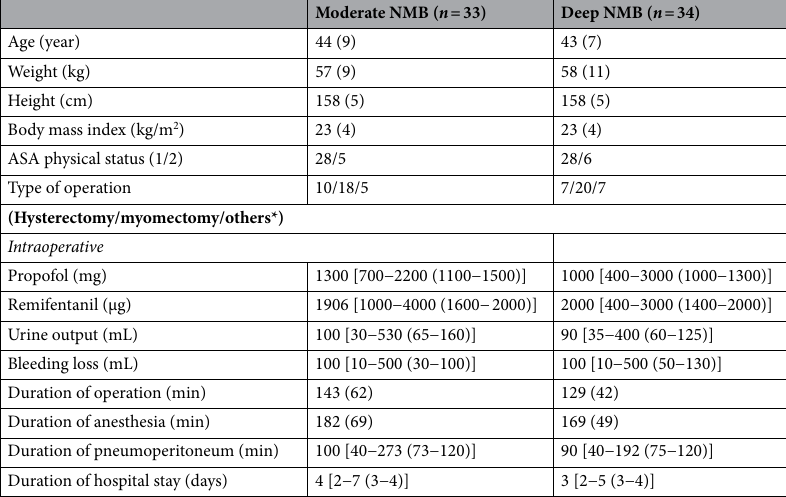
White blood cell counts and CRP levels were similar between the two groups (Table 3). The number of patients with CRP > 0.5 mg/dL was similar in the moderate and deep NMB groups [26 (79%) vs 30 (88%), P = 0.340]. The intergroup differences in changes in HR, MAP, pH, PaCO 2 , and PaO 2 /FiO 2 ratio from baseline were comparable over time ( P